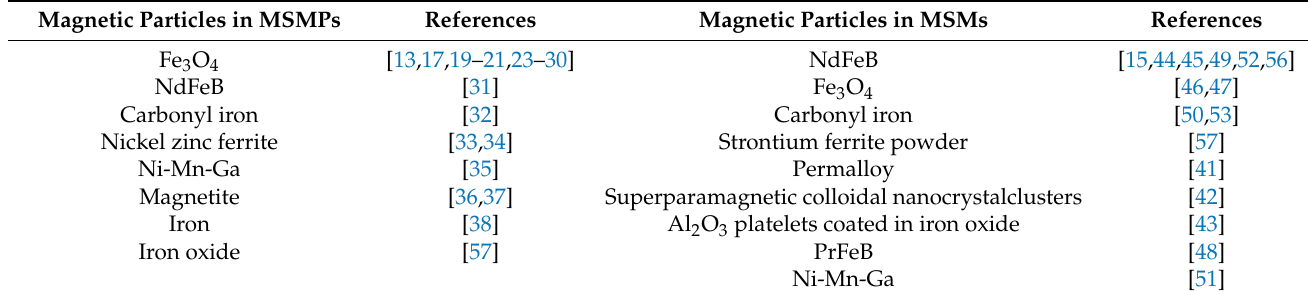
Table 2. Variety of Magnetic